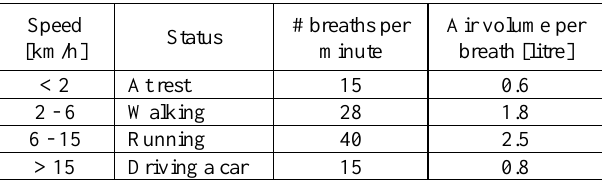
Table 1. Air intake estimation (per breath) based on 4 levels intensity physical activity performed by the user An interpolated pollution map is obtained applying the Gaussian kernel interpolation algorithm (Wilson and Nickisch, 2015) to the sensors’ measurements in order to estimate the pollution level in every location of the city. Figures 7 and 8 show, respectively, an interpolated map of an air pollution measurement coming from all the PurpleAir sensors deployed in Pavia and a trajectory of a user in the city. Putting those two things together, it is possible to estimate the intake of pollution (Figure 9) that was taken by the user considering their position in each specific time